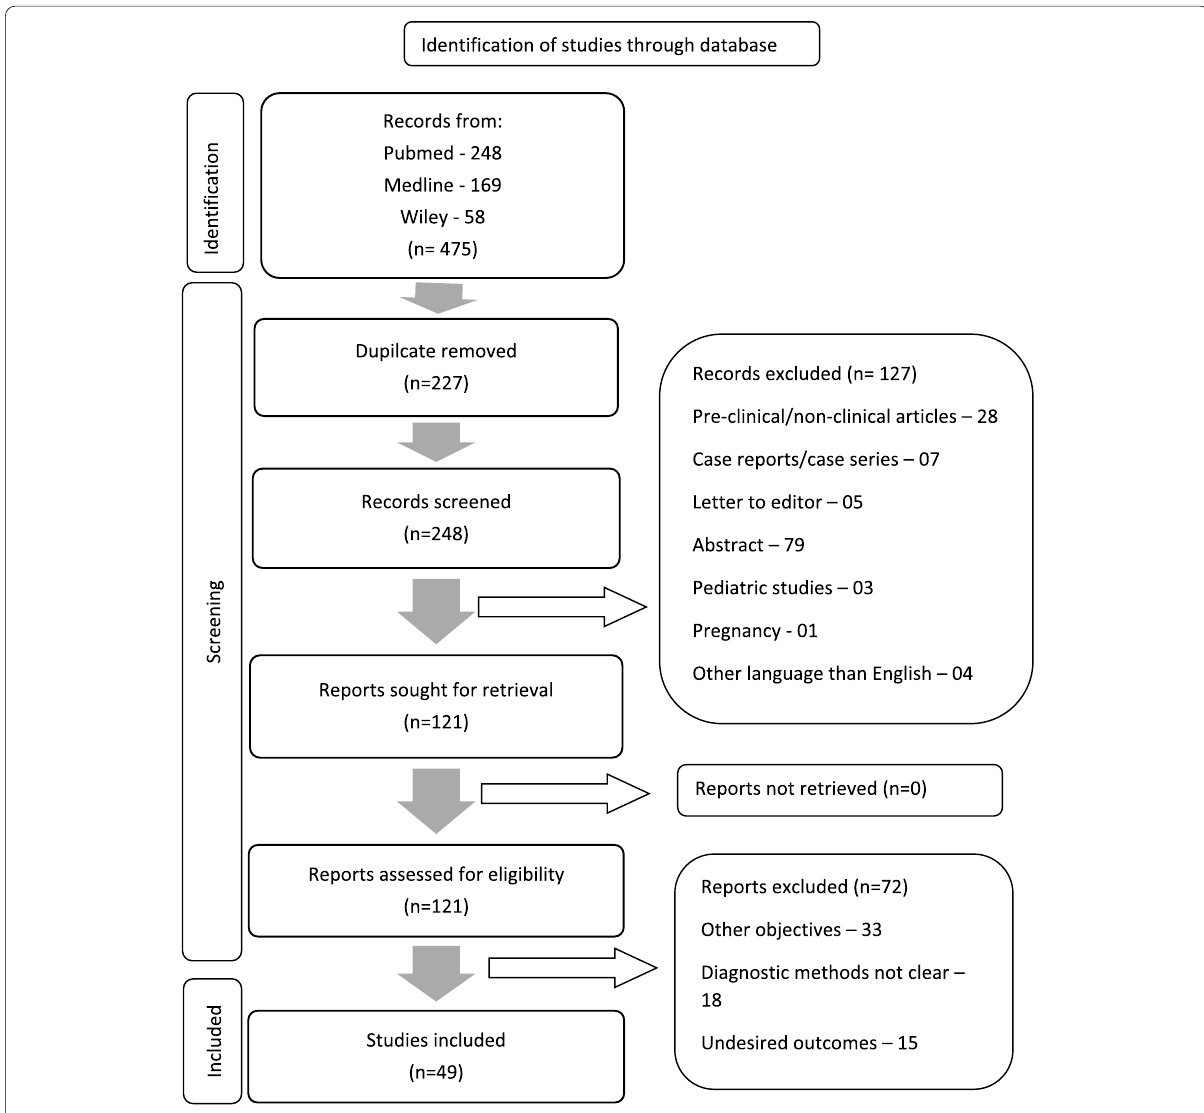
Fig. 2 Flow diagram of search methodology and literature selection